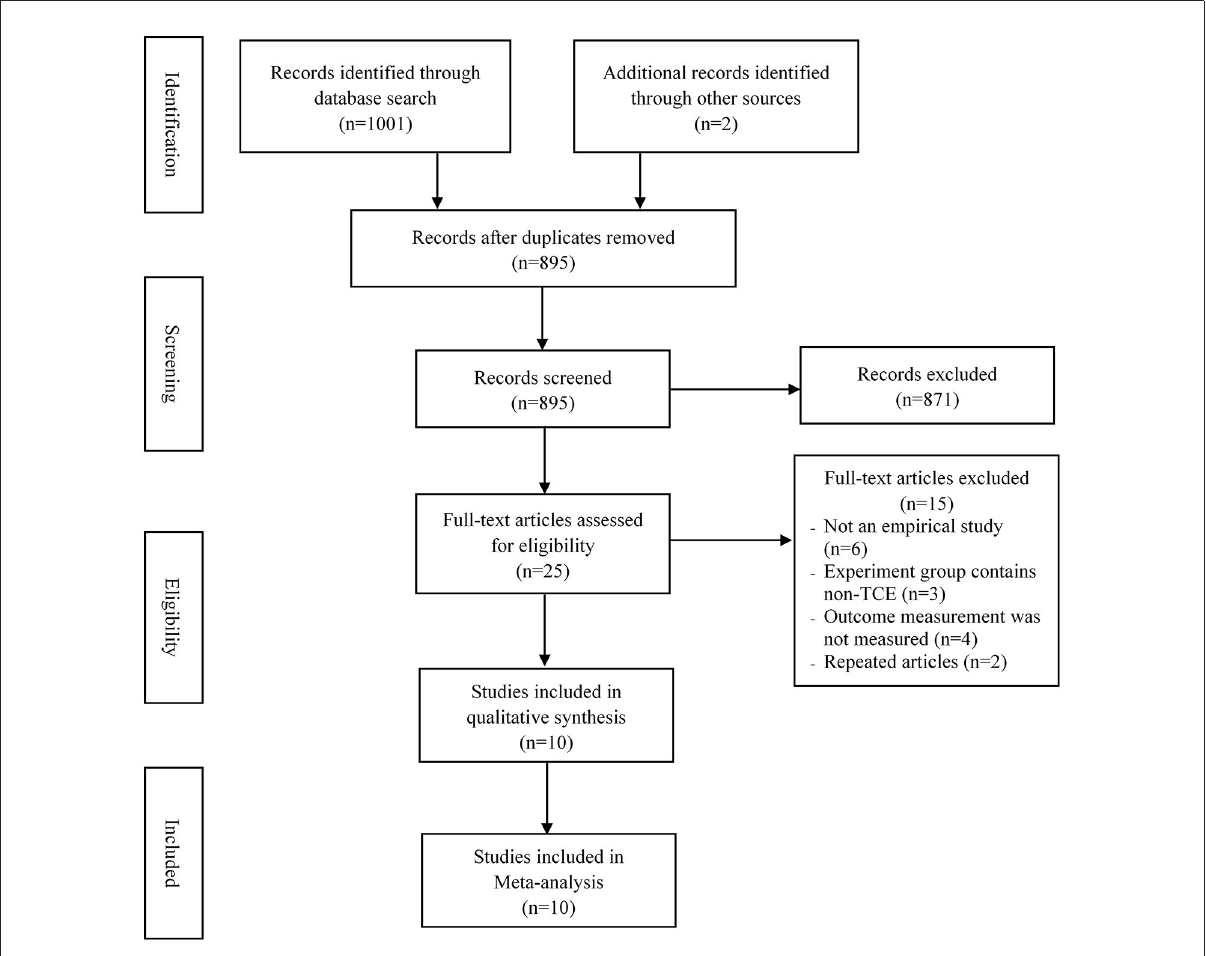
FIGURE1 The flowchart of the study selection